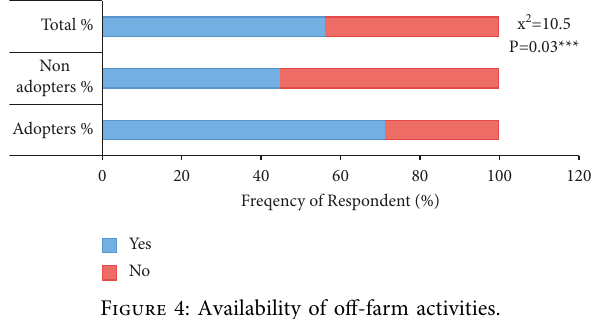
Figure 4: Availability of off-farm